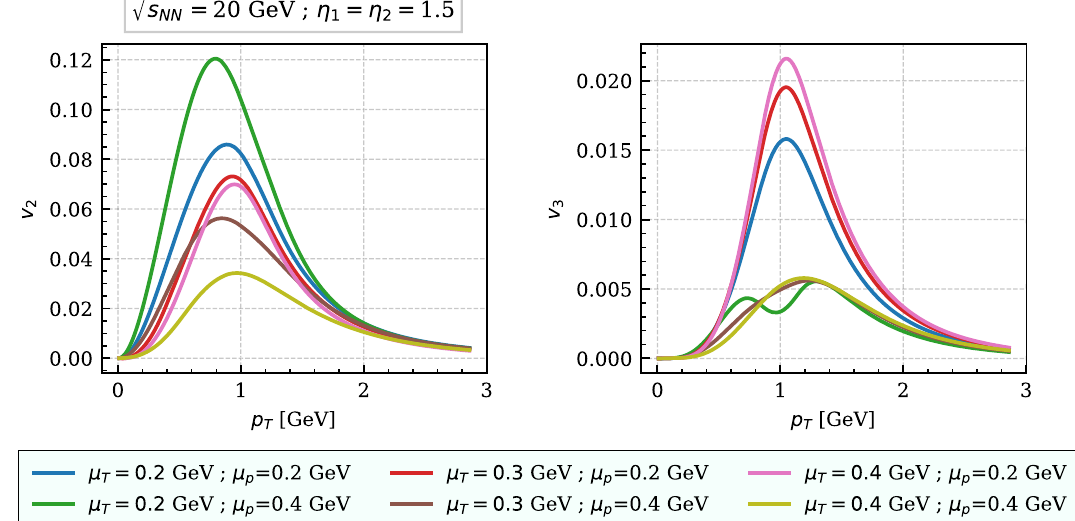
Fig. 1 Azimuthal harmonics v 2 ( p T ) and v 3 ( p T ) using the definition Eq. (18) for different values of μ T and μ P , excluding the HBT contribution, see the text. For these graphs we have taken p ref